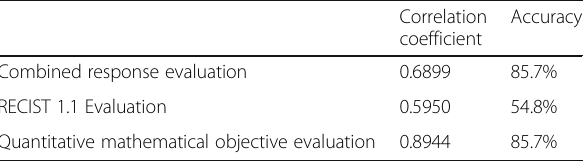
Table 5 Correlation coefficient between the different evaluation methods and the Miller – Payne Grade of the malignant lesions